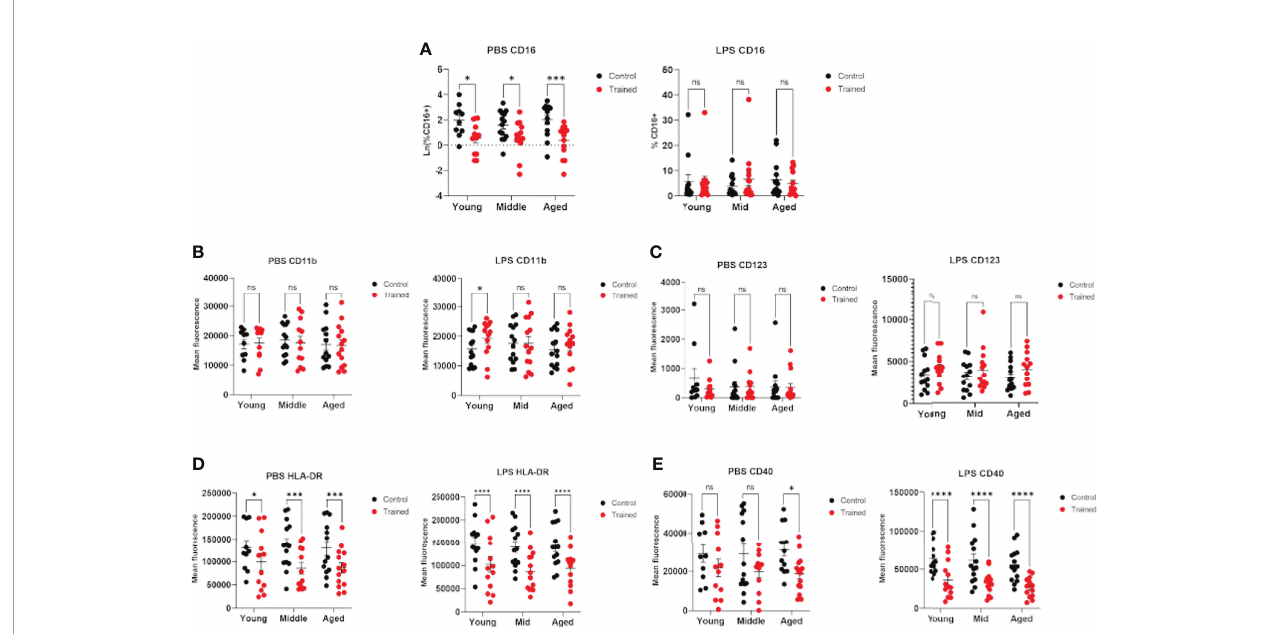
FIGURE 6 | Immune training with b – glucan alters monocyte phenotype. Isolated human monocytes were trained with b – glucan or vehicle control and allowed to rest for 7 days. After 7 days, monocytes were treated with LPS (10ng/mL) or PBS (baseline control) for 24 hours. Cell surface markers were analyzed by fl ow cytometry. (A) Scatterplot depicting the percent of isolated CD14+ monocytes expressing CD16 in LPS – stimulated and unstimulated cells. (B) Mean fl uorescence of CD11b/ Mac – 1. (C) Mean fl uorescence of cell surface CD123. (D) Mean fl uorescence of cell surface HLA – DR. (E) Mean fl uorescence of cell surface CD40. All results analyzed using a mixed effect model and S ̌ ı ́ da ́ k ’ s multiple comparisons test (*P ≤ 0.05, ***P ≤ 0.001, ****P ≤ 0.0001) (N=10 – 14). ns, not signi fi